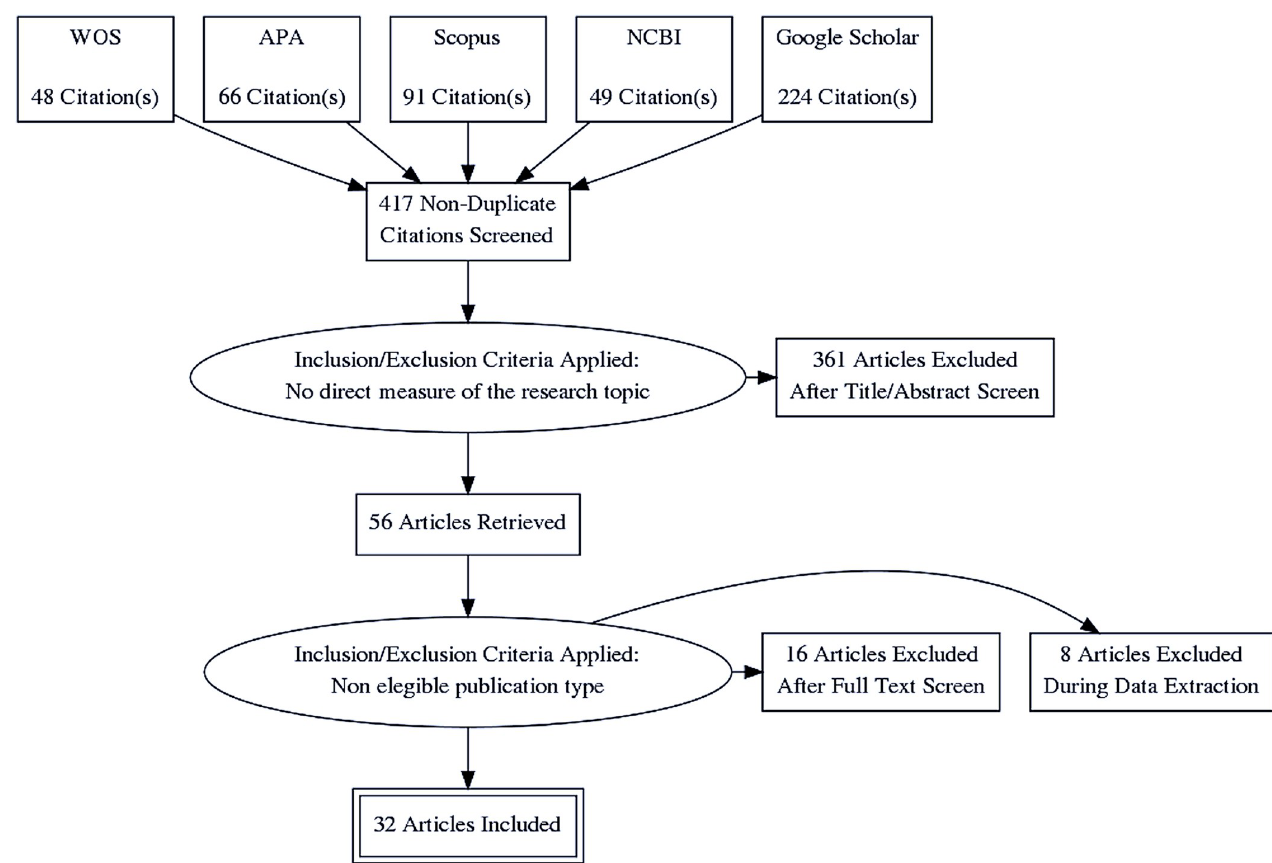
Fig 1. PRISMA diagram appending non-duplicate search results according to the different data sources. Abbreviations: WOS (Web of Science); APA (American Psychological Association); NCBI (National Center for Biotechnology Information).